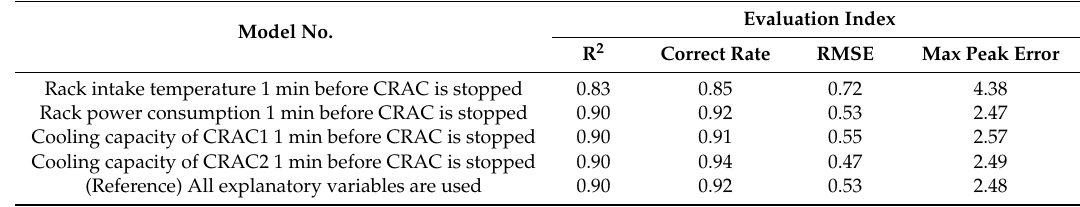
Table 16. Evaluation values when one of the explanatory variables was deleted. Model No.